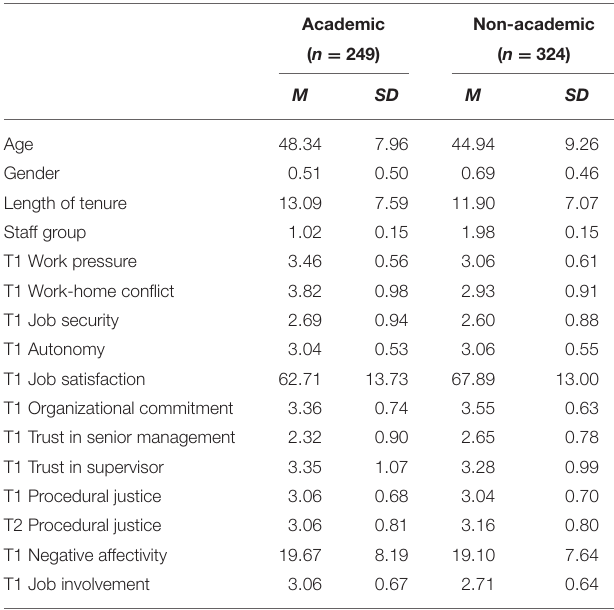
Coding: Gender (Male = 1, Female = 2),Staff Group (Academic = 1,Non-academic =